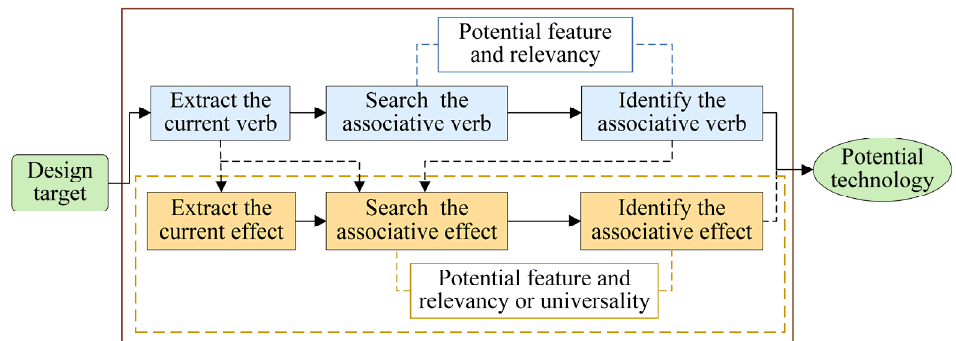
Figure 6. Acquisition process of the potentially new